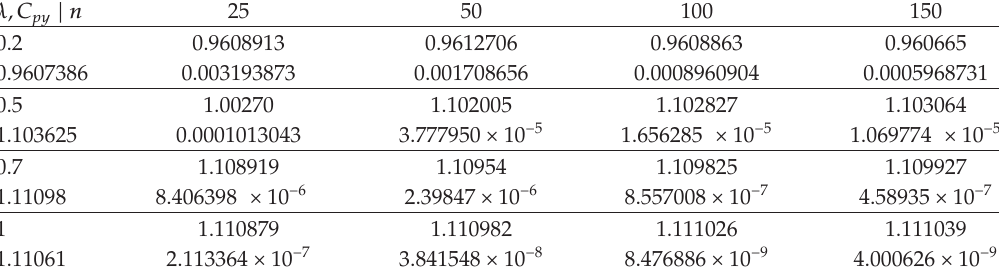
(cid:7) 0, U (cid:7) 10, samples generated from exponential